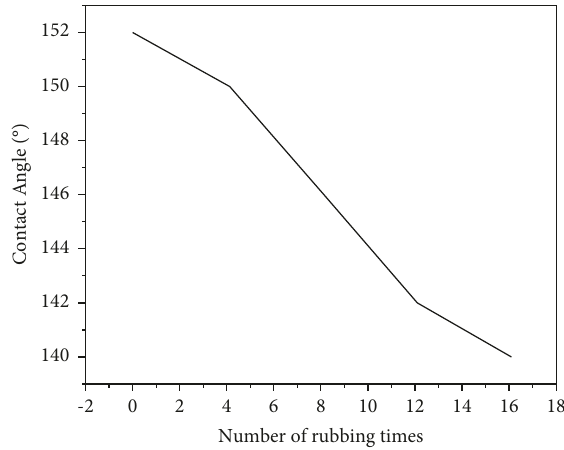
Figure 6: The contact angle of the surface of the transverse groove changes with the number of friction.